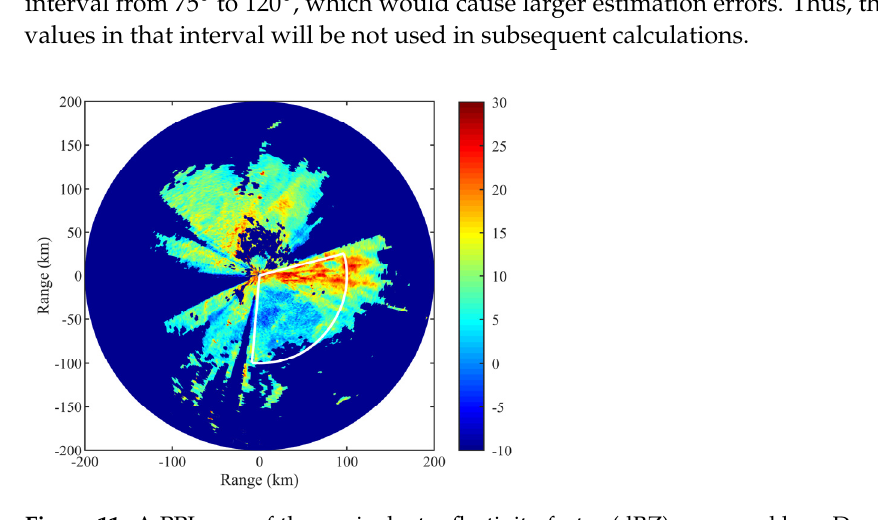
Remote Sens. 2021 , 13 , x FOR PEER REVIEW 14 of 25